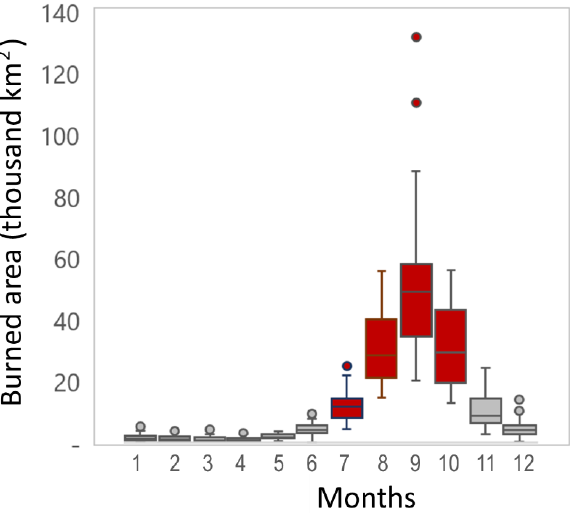
Figure 9. Seasonal patterns of fire events occurred in Brazil, considering the variation of burned